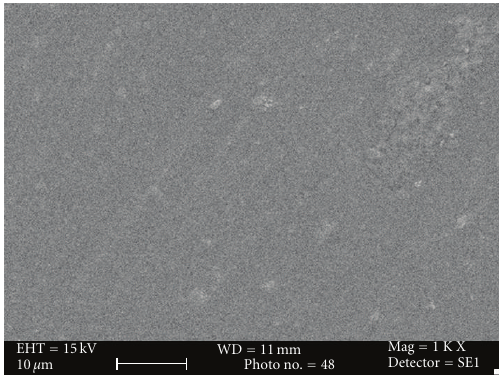
Figure 3: Photomicrograph of Filtek Z350 after bleaching at 1000x.